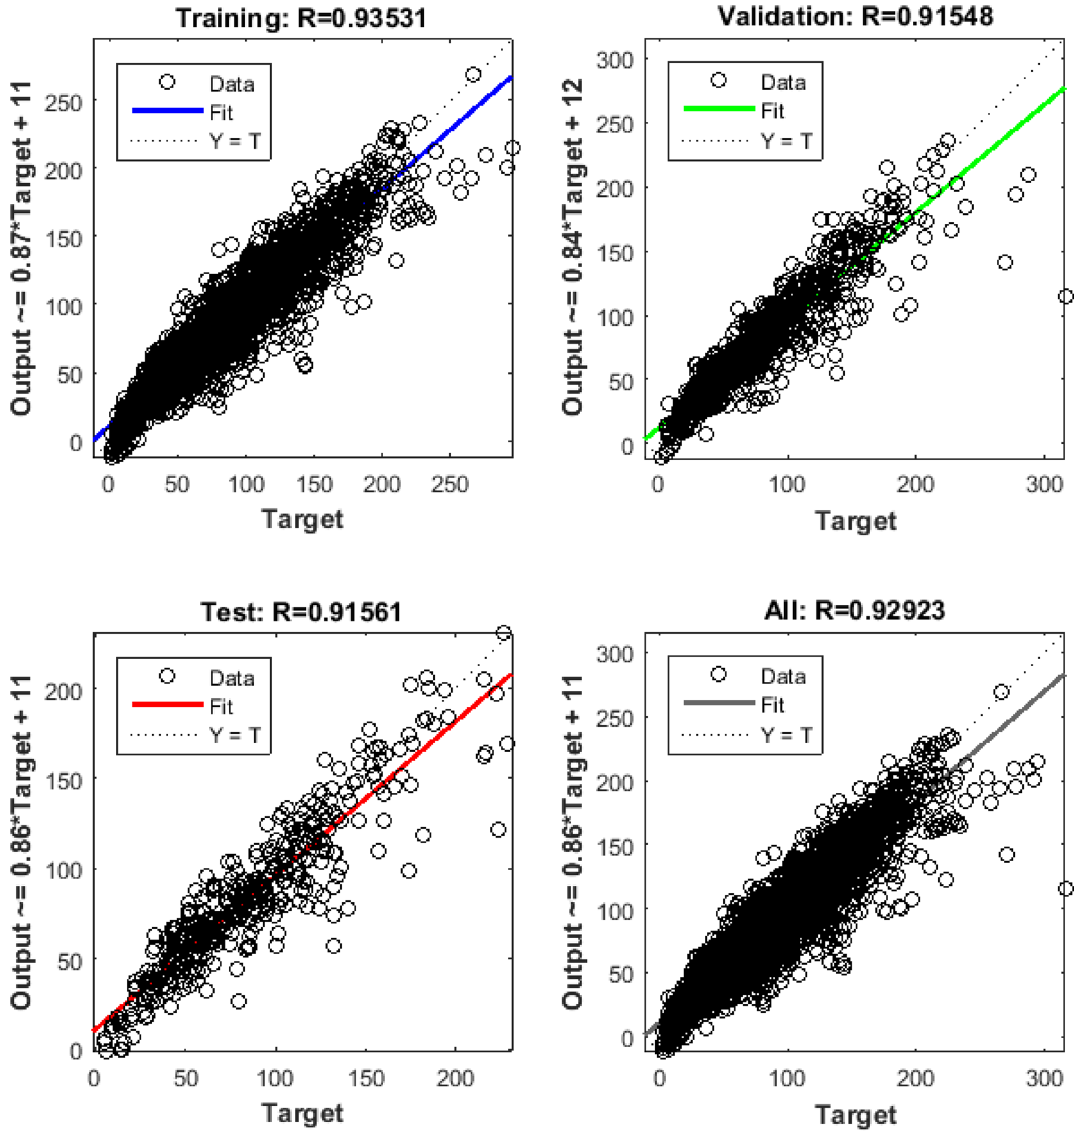
Figure 6. The prediction effect of PM10’s SRA-MLP model on the training set, validation set and test